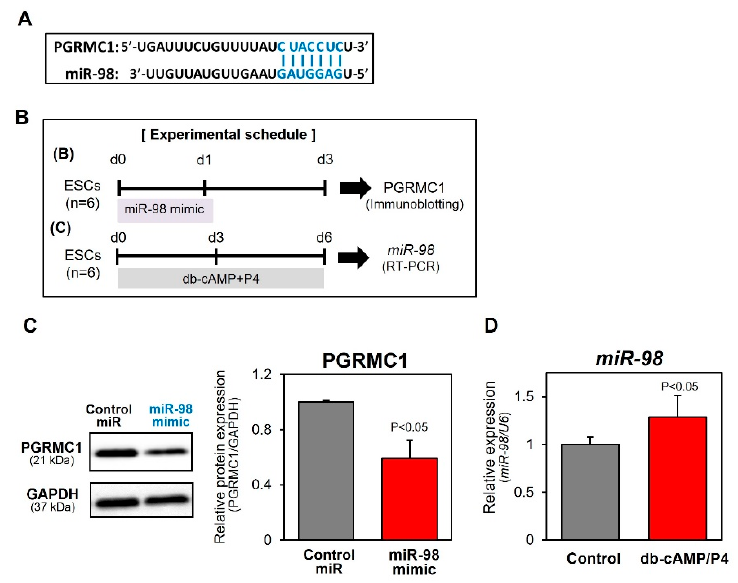
Figure 5. Effects of miR-98 mimic transfection on PGRMC1 expression and of db-cAMP/P4 treatment on miR-98 expression in ESCs. ( A ) Sequence of miR-98 and its possible interaction with PGRMC1. ( B ) Experimental schedules. ( C ) ESCs were transfected with the control miR or miR-98 mimic for 24 h and then cultured for 2 days. PGRMC1 levels were assessed by immunoblot analysis. The graph shows the relative levels of PGRMC1 normalized to those of GAPDH in three independent experiments. ( D ) ESCs were treated without (control) or with db-cAMP/P4 for 6 days. Total RNA was subjected to real-time RT-PCR analysis to determine the expression levels of miR-98. U6 served as an internal control. Data represent the mean ± SD of three independent experiments.